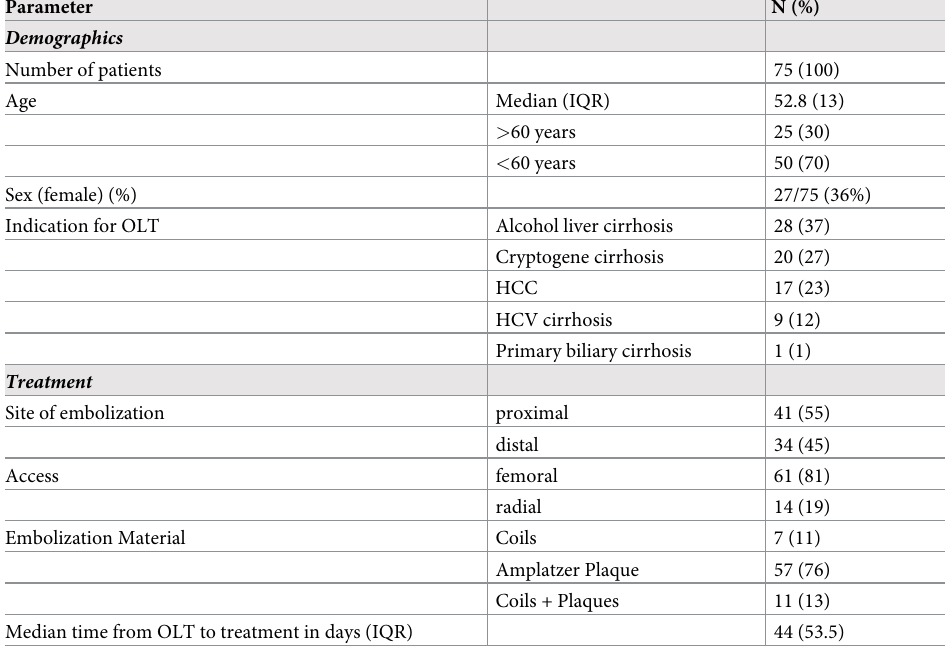
Table 1. Patient